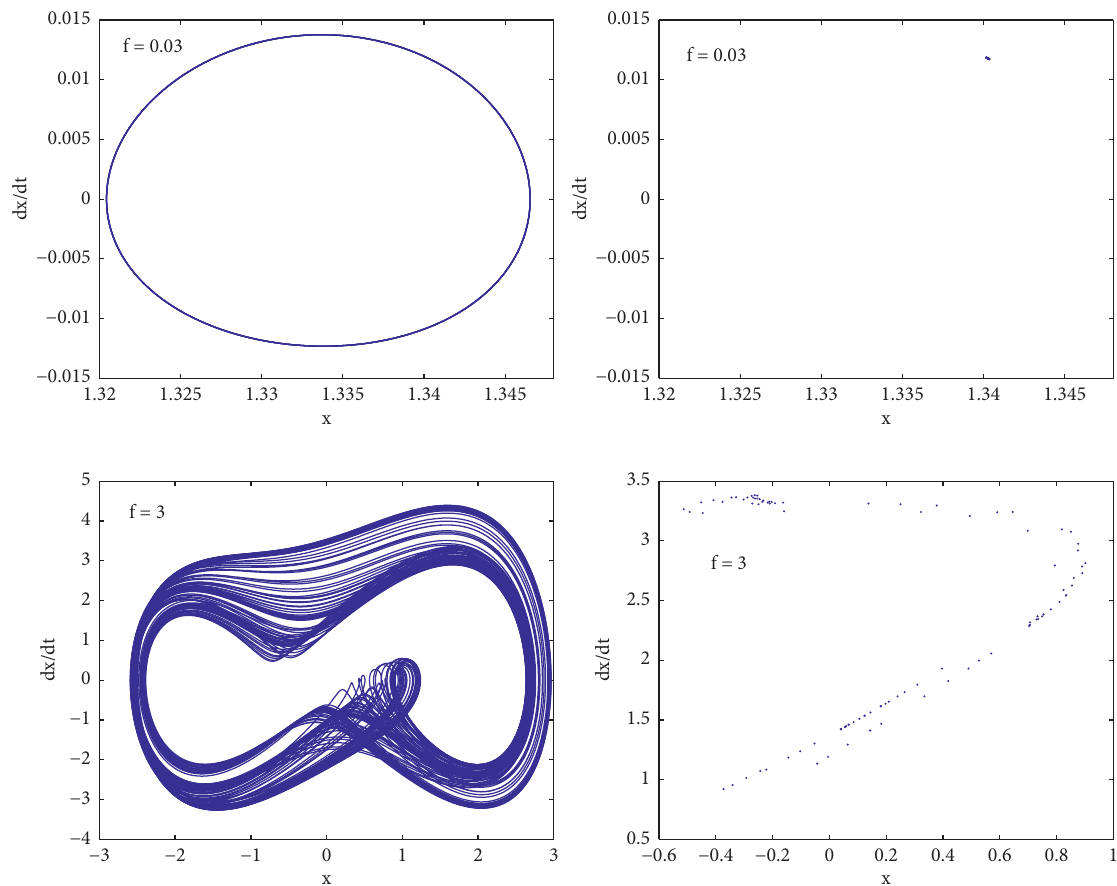
Figure 1: Phase portraits and its corresponding Poincar´e maps showing the validation of the proposed analytical prediction of horseshoe chaos in the case ω � Ω .